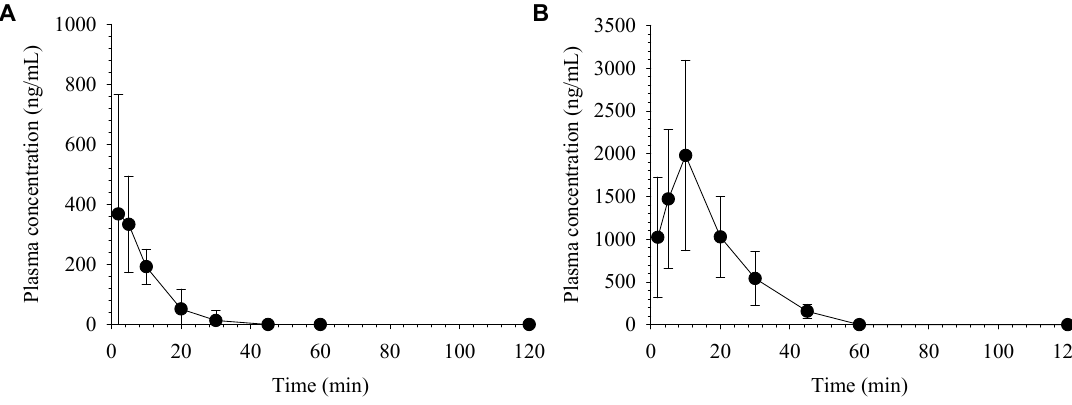
Figure 4. Average plasma concentration vs. time profiles of desoxo-narchinol A after (A) intravenous administration at a dose of 2 mg/kg ( n = 6) and (B) oral administration at a dose of 50 mg/kg ( n = 5) in mice. Data represent the mean ± SD.